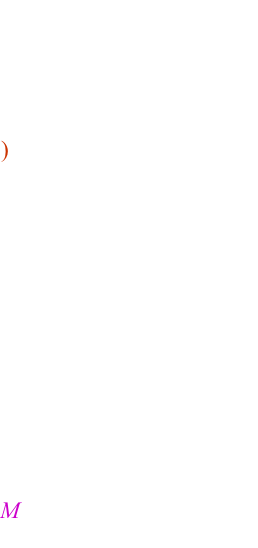
Fig. 1 Magnetic-field “flipper”. A summation of the contributions from the EDM and the MDM leads to the collinearity of the constant and oscillating parts of the vector (cid:4) ( cyl ) . A resonance effect does not exist (cid:4) ( cyl ) = (cid:4) ( 0 ) + (cid:4) ( 1 ) cos (ω t + χ).